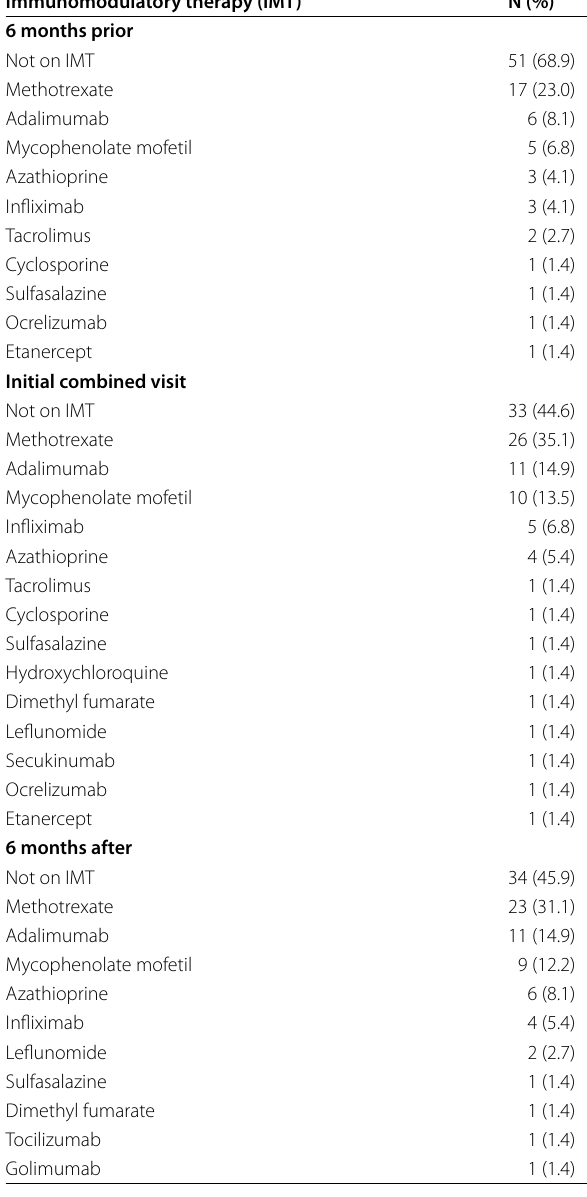
Table 2 The number and frequency of patients on individual immunomodulatory agent Immunomodulatory therapy